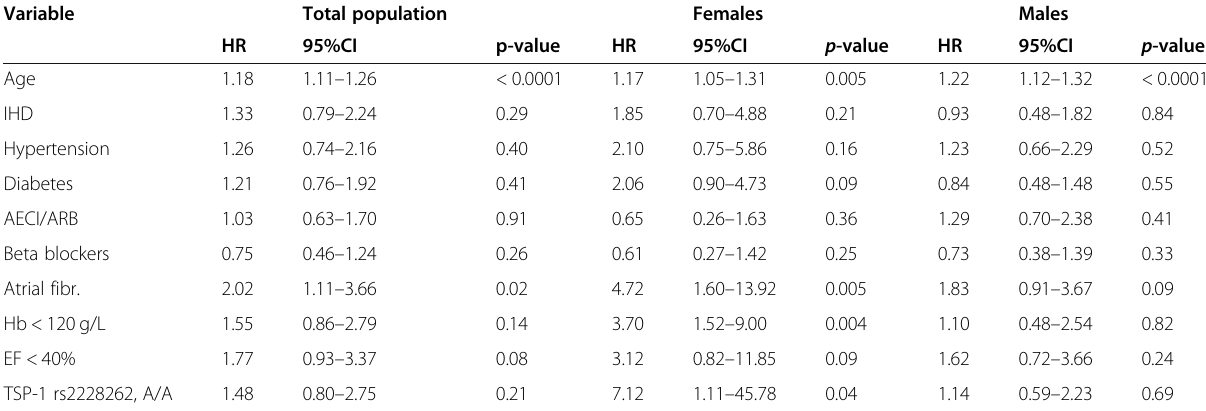
Table 6 Cox proportional hazard regression analysis evaluating risk of cardiovascular mortality in the study population divided in the total population, and into the two genders regarding rs2228262 of TSP-1 Variable Total population